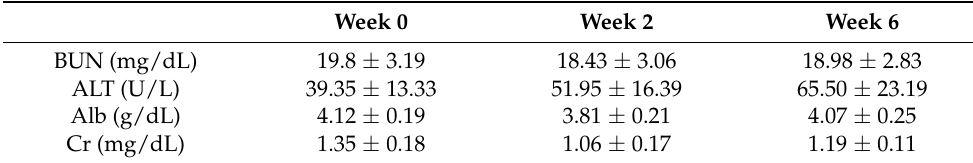
Table 1. Blood biochemistry analysis.